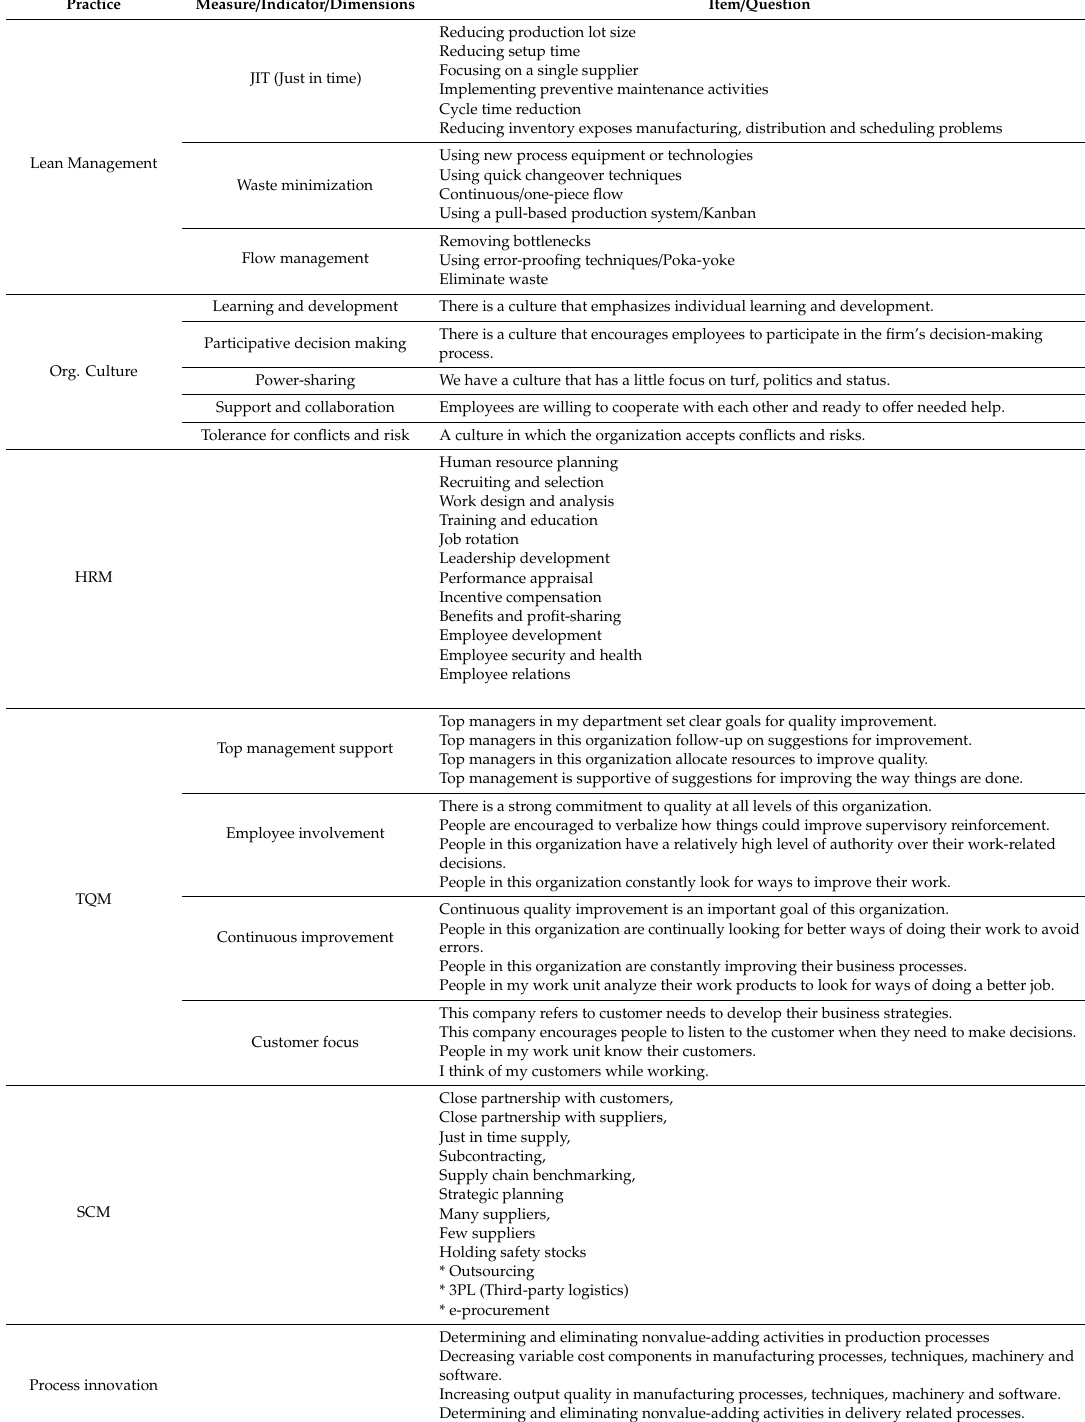
Table A1. Description of the practices